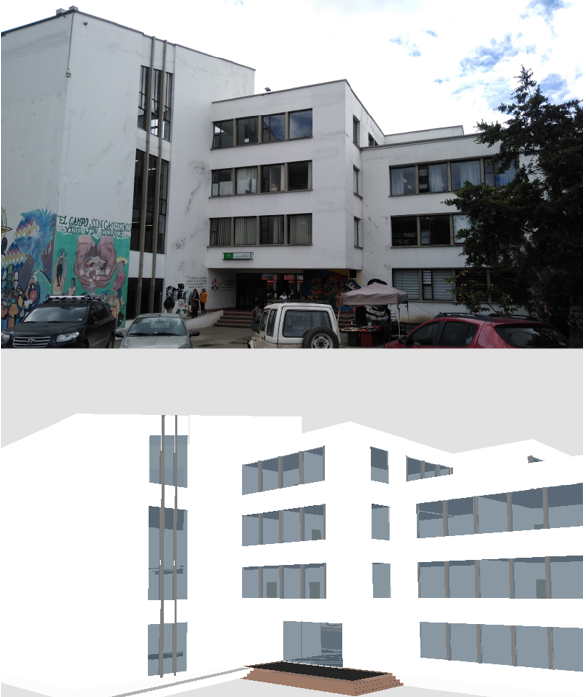
Figure 7. Main entrance of the